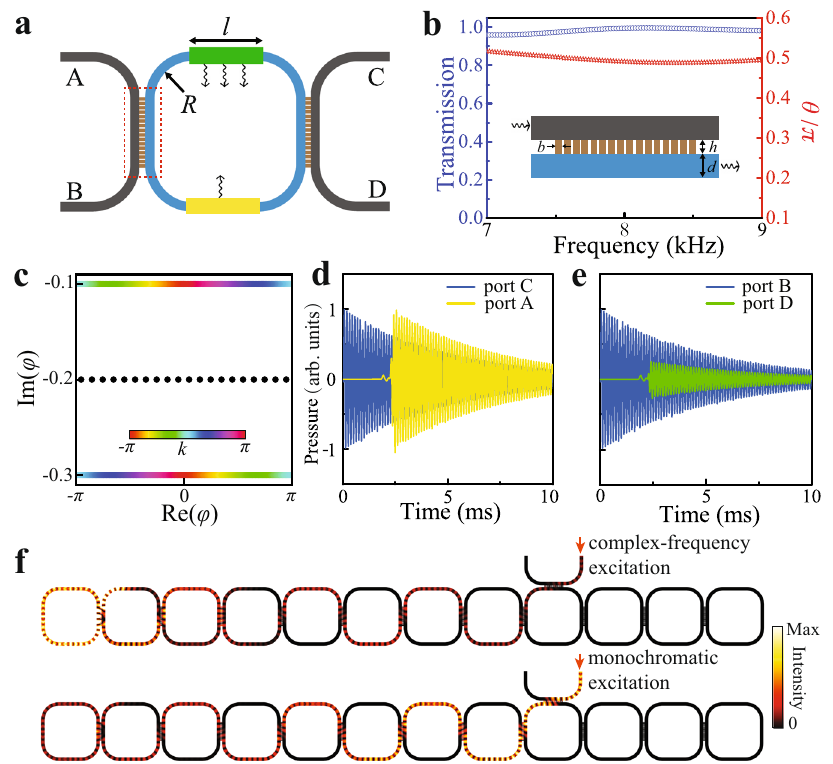
Fig. 3 | Numerical results for the acoustic ring resonator lattice. a The acoustic unitcell. The radius, R , of the circularpart is 5.6cm and the width, l , of the straight part is 9.6cm. The green and yellow areas with arrows represent areas with dif- ferent losses. The red dashed boxes denote the coupling regions. b Plots of θ (red stars)andthetransmissioncoef fi cient(bluecircles)betweentwoneighboringrings against frequency. The inset shows the simulation geometry, which consists of an array of narrow waveguides (16 in total) that are used to couple the neighboring rings. The width and thickness of each narrow tube h =0.7cm and b =0.35cm, arrayedwithaperiodof0.47cm.Thewidth, d ,oftheringresonatoris1.4cm. c The